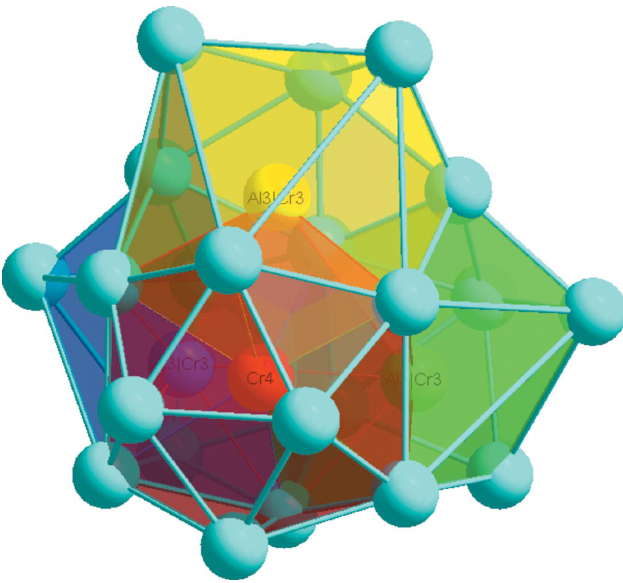
Figure 3 26-atom (cid:2) -brass-type cluster represented as four interpenetrating distorted icosahedra centred at one Cr4 and three Al3/Cr3 sites.